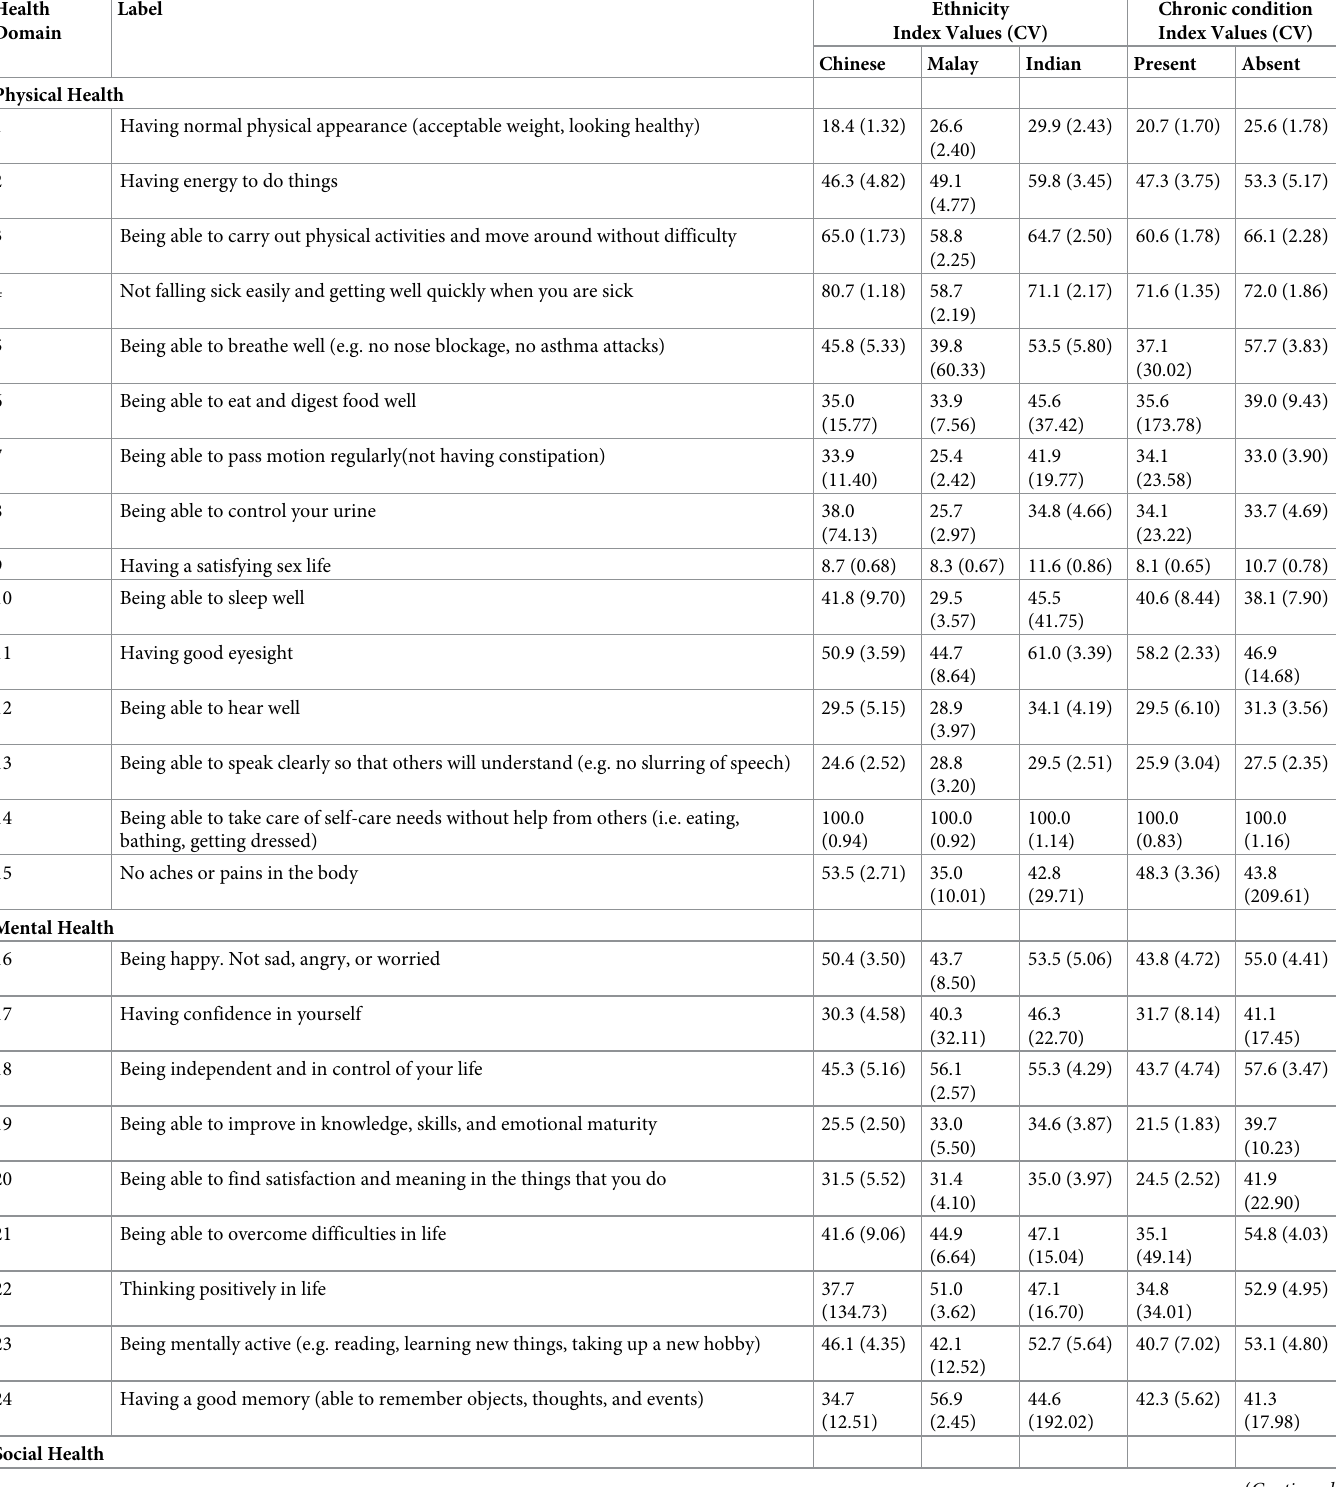
Table 6. Importance ranks (index values, IV) and consistency of ranks (coefficient of variation, CV) by ethnicity and presence of chronic conditions. Health